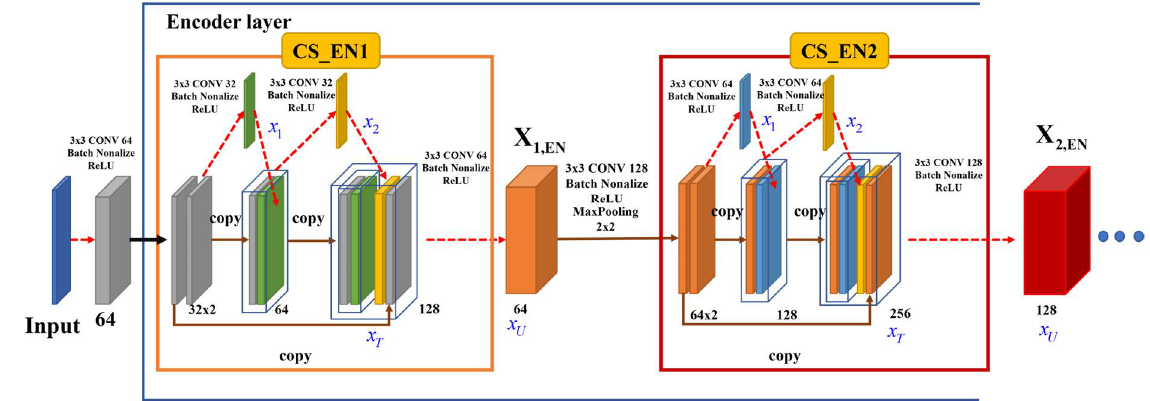
Figure 10. Proposed CS_EN.